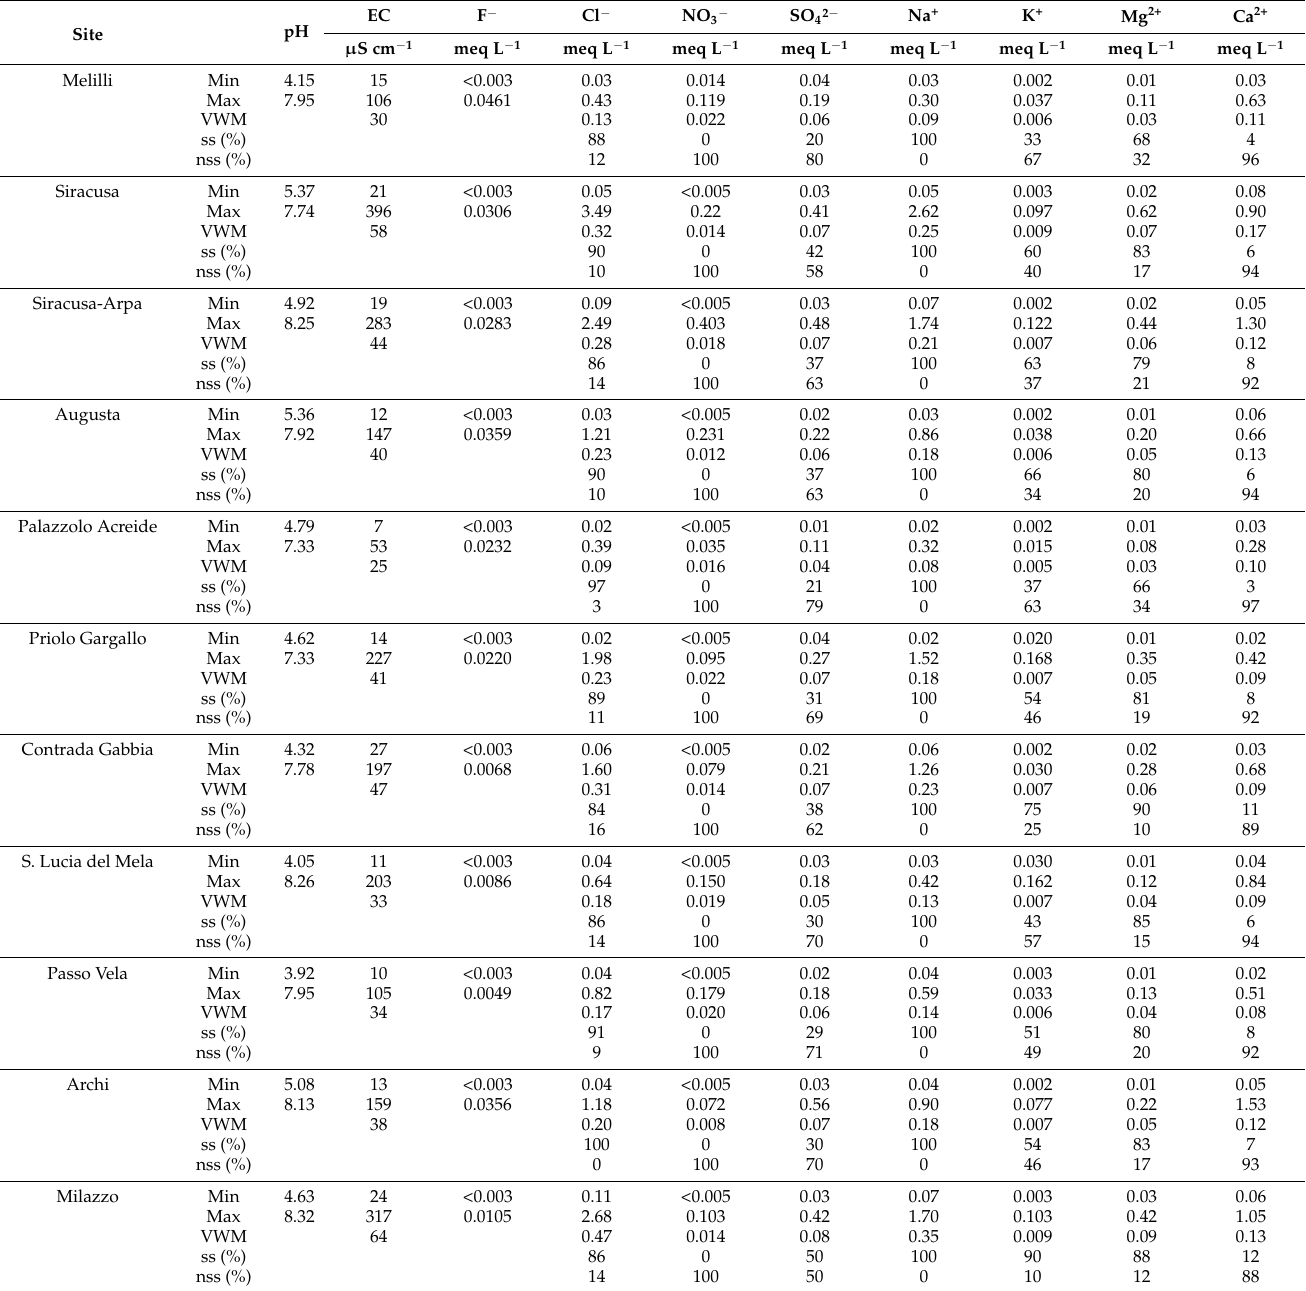
Table 2. Statistical information on the measured pH, electrical conductivity ( µ S cm − 1 ), and major ion concentration (meq L − 1 ) values, for both the study areas. VWM = volume-weighted mean. ss% = percent of sea salt contribution calculated on the VWMs. nss% = percent of non-sea salt contribution calculated on the